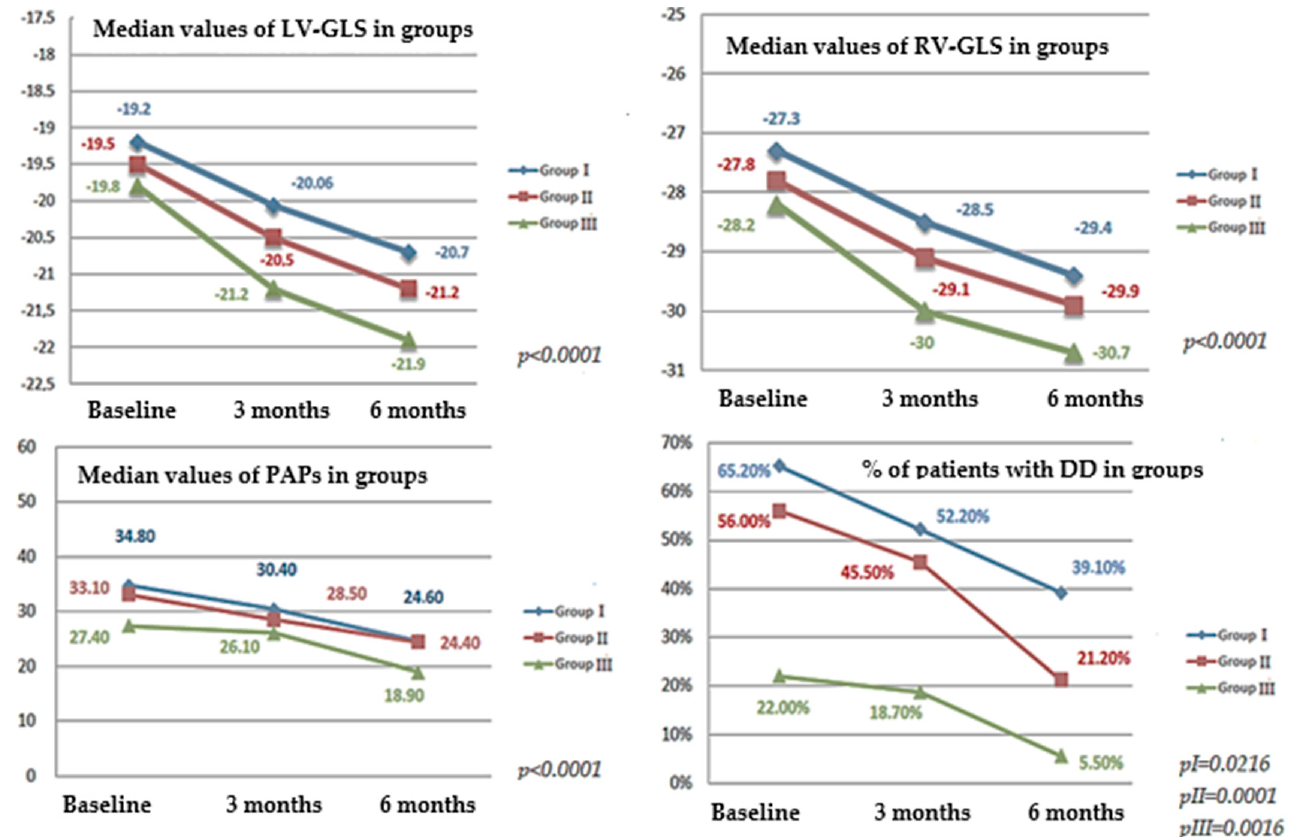
Figure 2. The 6 months evolution of principal cardiac abnormalities assessed by TTE: LV-GLS, RV-GLS, PAPs and DD. Legend: LV-GLS—left ventricular global longitudinal strain; RV-GLS-right ventricular global longitudinal strain; PAPs—systolic pressure in the pulmonary artery; DD—summation of factors: E/A and E/e’ ratio, LAVI and TRV.